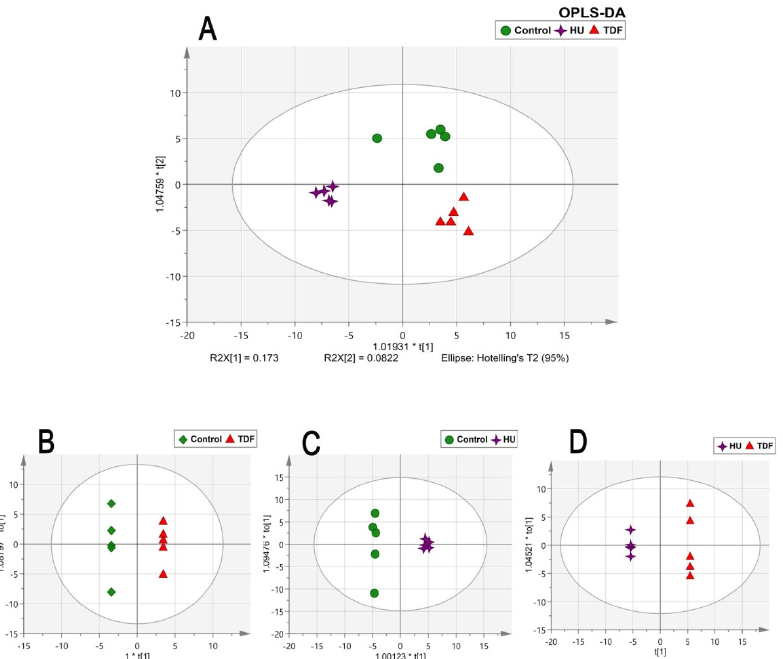
Figure 3 . OPLS-DA statistical models for different groups. ( A ) Model with all three groups: green circles = untreated control, red triangles = β -YAC transgenic mice treated with TDF, and purple four- pointed star = β -YAC transgenic mice treated with HU. ( B ) Model comparing untreated control and treated mice with TDF for β -thalassemia. ( C ) Model comparing untreated control and treated mice with HU for β -thalassemia. ( D ) Model comparing treated mice with TDF and HU for β -thalassemia.